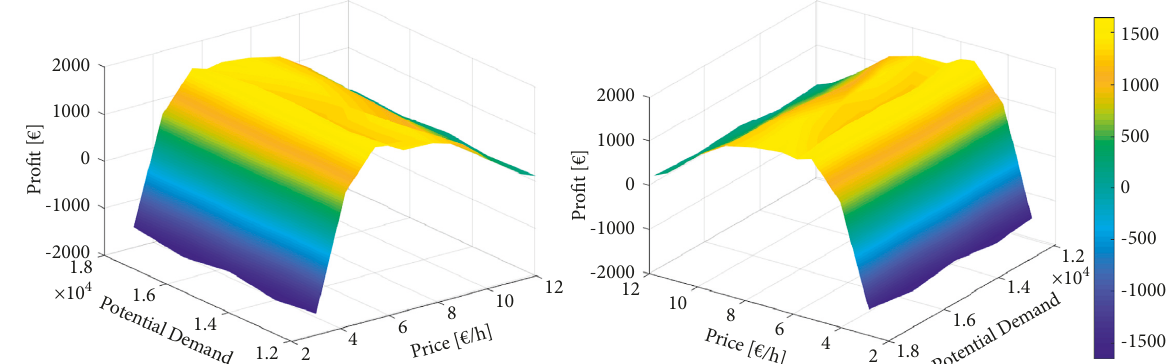
Figure 6: Dual perspective of profit as a function of the potential demand and price